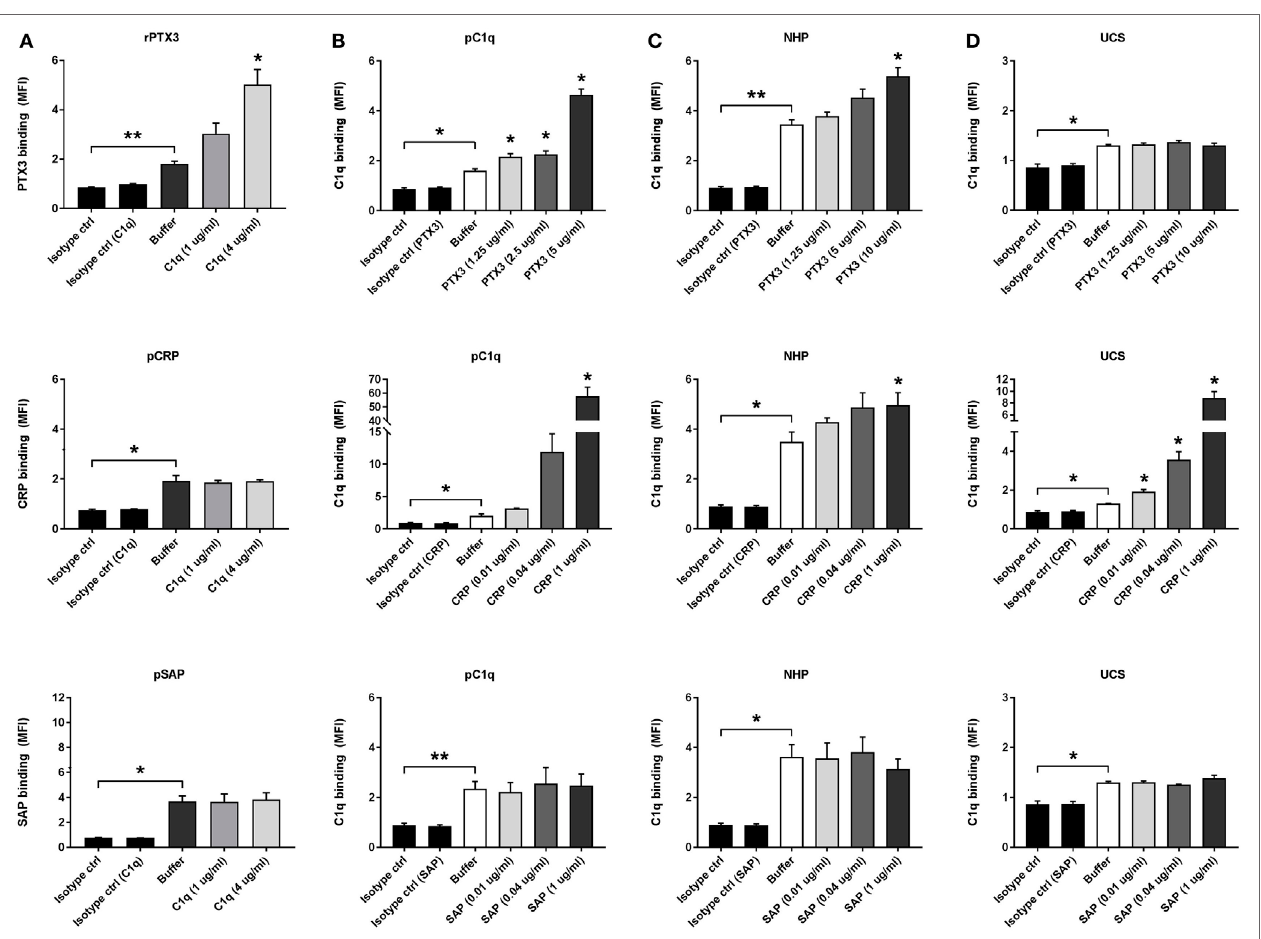
FigUre 3 | Pentraxin 3 (PTX3), C-reactive protein (CRP), and C1q interact on the surface of CCs. C1q binding to CC increase binding of PTX3 (a) and binding of PTX3 or CRP increase the binding of purified C1q (pC1q) and native C1q from plasma or serum samples (B–D) . (a) Binding of recombinant PTX3 (rPTX3) (2.5 µg/mL), purified CRP (pCRP) (0.02 µg/mL), or purified SAP (pSAP) (0.02 µg/mL) to CC preincubated with 0, 1, or 4 µg/mL pC1q. (B) Binding of pC1q (2 µg/mL) to CC preincubated with rPTX3 (0, 1.25, 2.5 or 5 µg/mL), pCRP (0, 0.01, 0.04, or 1 µg/mL), or pSAP (0, 0.01, 0.04, or 1 µg/mL). (c) Binding of C1q from 5% NHP to CC preincubated with rPTX3 (0, 1.25, 5 or 10 µg/mL), pCRP (0, 0.01, 0.04, or 1 µg/mL), or pSAP (0, 0.01, 0.04, or 1 µg/mL). (D) Binding of C1q from 5% UCS to CC preincubated with rPTX3 (0, 1.25, 5, or 10 µg/mL), pCRP (0, 0.01, 0.04, or 1 µg/mL), or pSAP (0, 0.01, 0.04, or 1 µg/mL). Binding was assessed by MFI and data are given as mean ± SEM ( n = 3). * p < 0.05, ** p < 0.01 compared with buffer or as otherwise indicated. CC, cholesterol crystals; NHP, normal human plasma; UCS, umbilical cord serum; MFI, median fluorescence